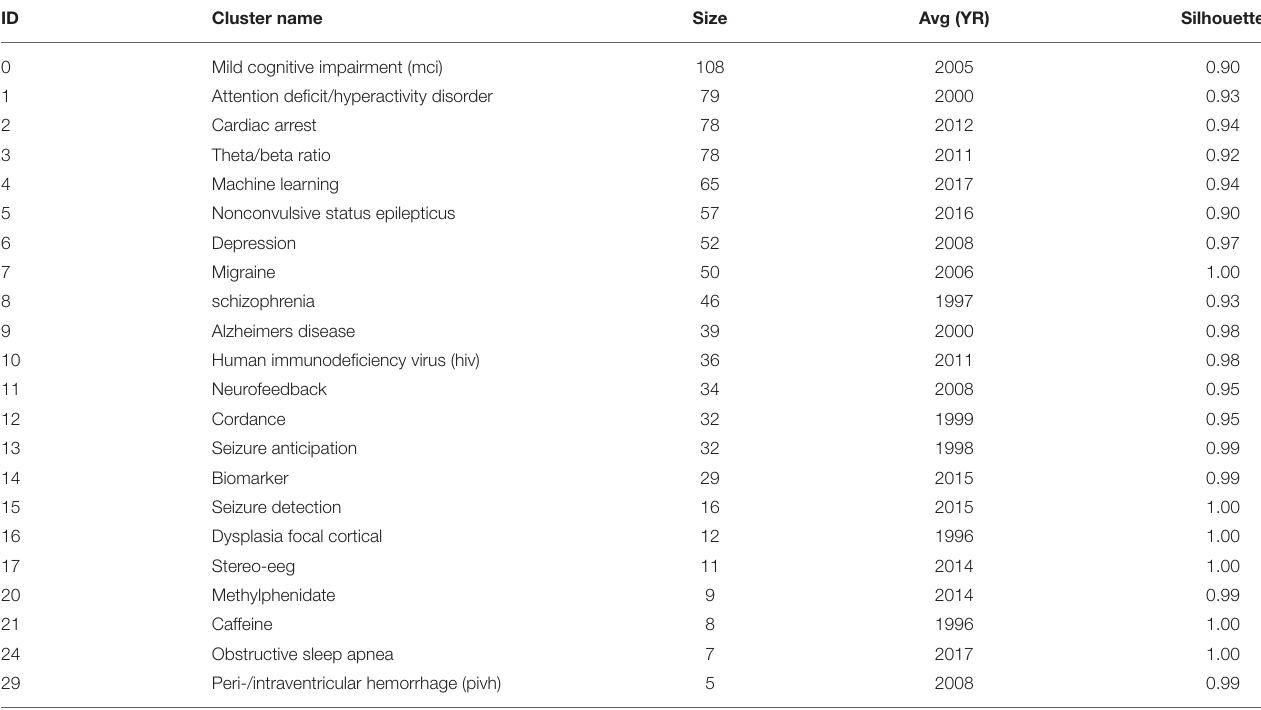
TABLE 3 | Basic information of the co-cited reference clusters.